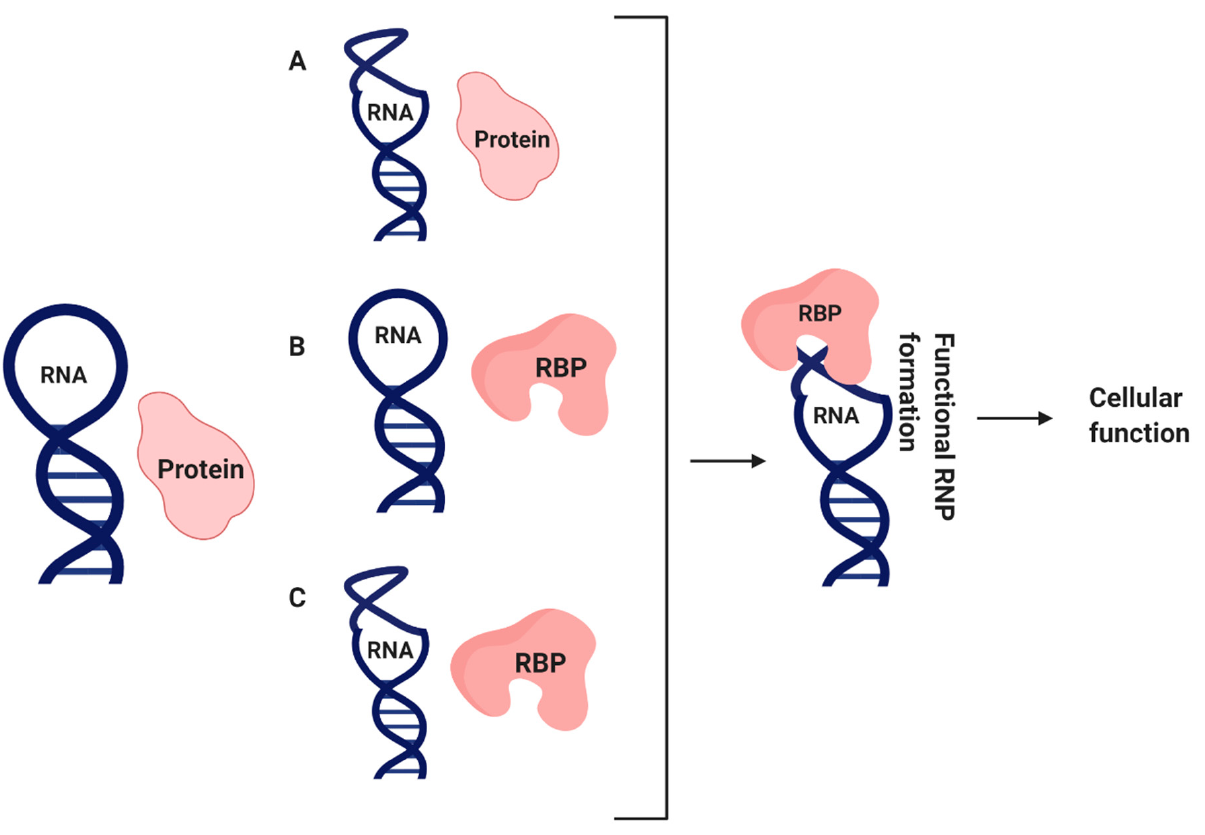
Figure 1. Observed conformational changes during RNA–protein interactions. Protein-induced RNA folding ( A ), RNA- induced protein folding ( B ), and co-induced folding ( C ) [3].